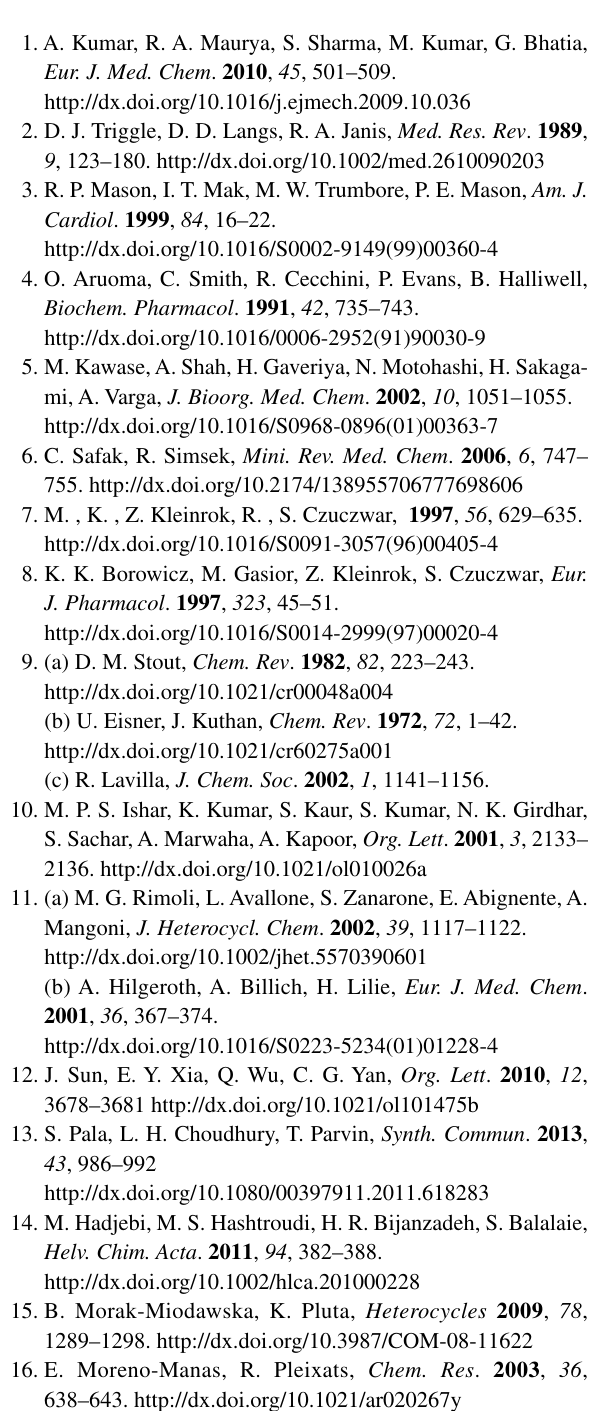
Table 4. Reusability of the Fe